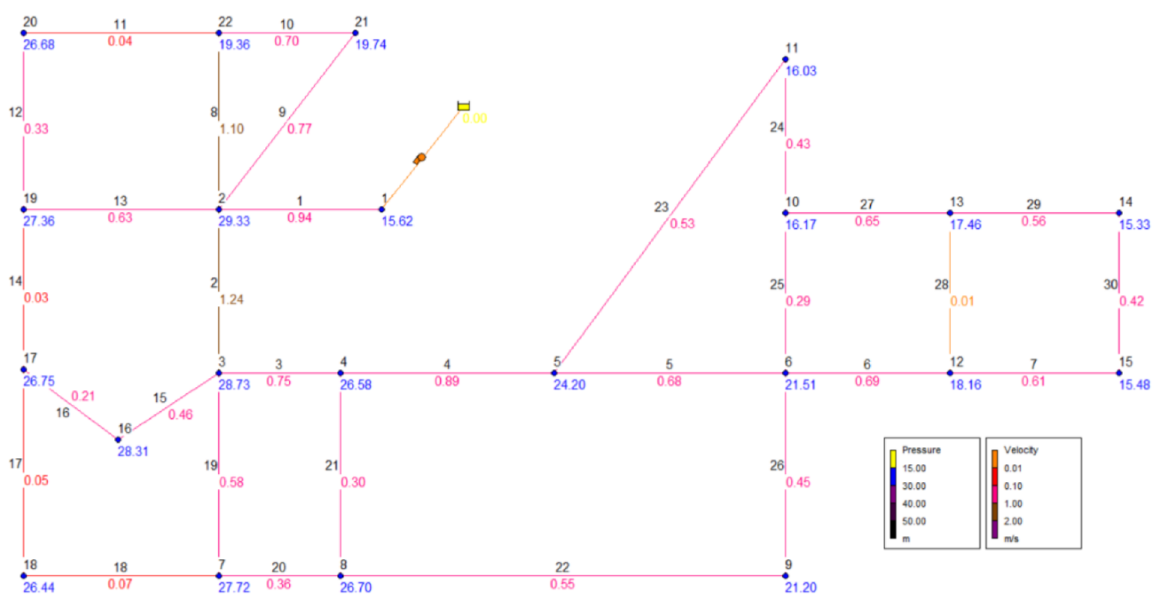
Figure 13. The GoYang network solution obtained (pressure and velocity).